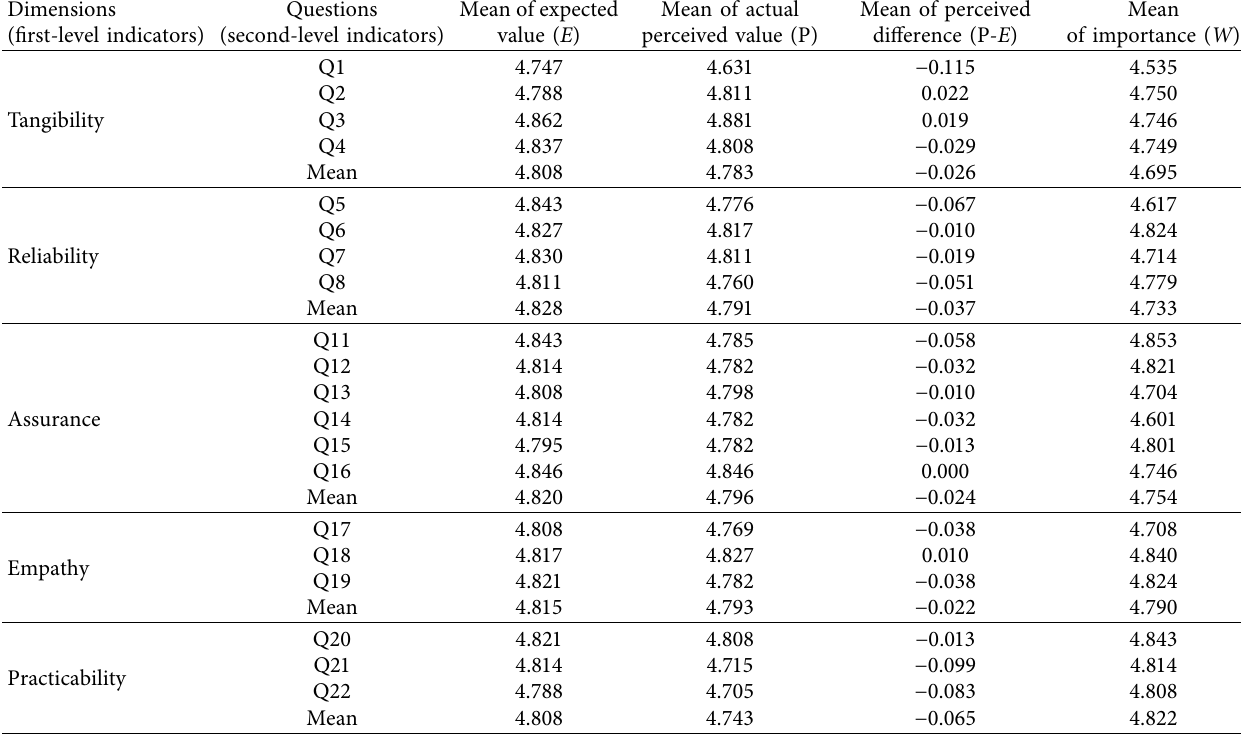
Table 3: Mean value analysis of each dimension and problem index of student classroom